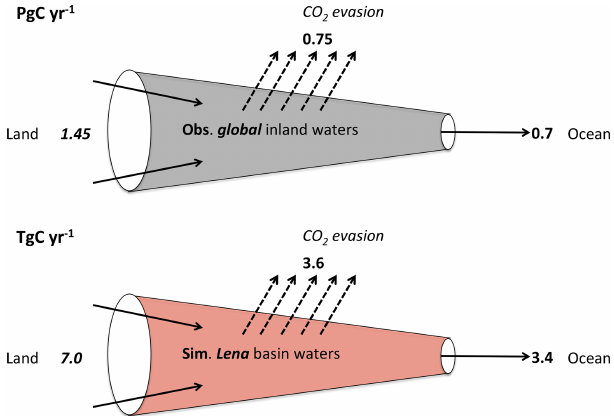
Figure 10. Simplified “leaky pipe” diagram representing the transport and processing of DOC within the land–ocean hydro- logic continuum. The scheme template is taken from Cole et al. (2007), where we reproduce their global estimate of DOC and non-groundwater discharge portion of this flow in the top panel (PgCyr − 1 ) , and the equivalent flows from our Lena basin simu- lations (TgCyr − 1 ) are in the bottom panel. Thus easy comparison would look at the relative fluxes within each system and compare them to one